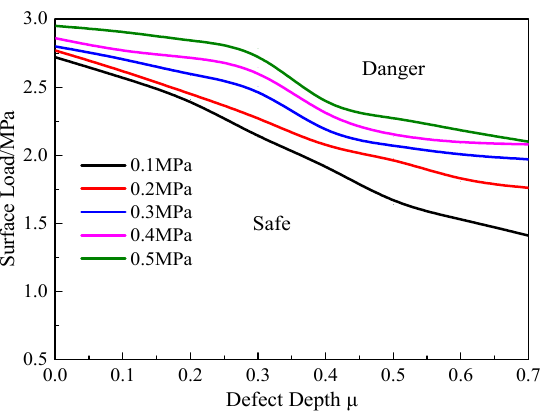
Figure 28. Defect depth-critical surface load curves for different internal pressure loads (60–90°). Formulae for the ultimate surface load, defect depth, and internal pressure of the pipeline when the defect was located at 60°–90° can be obtained according to the failure evaluation curves. The R-squared value of the correlation coefficient is 0.942.